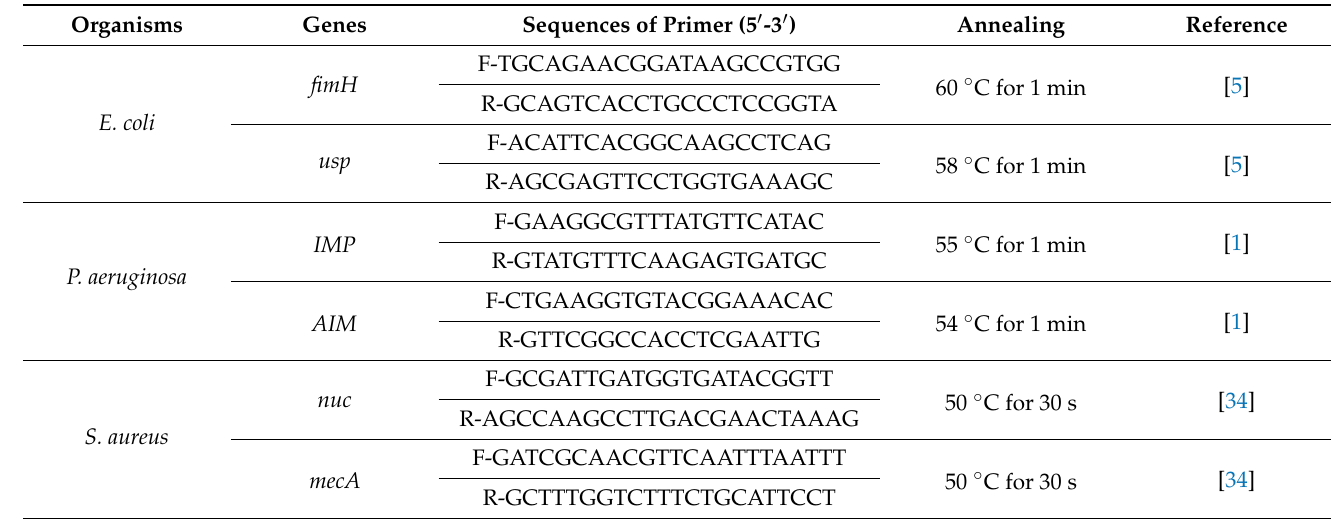
Table 4. Primer sequences of genes of E. coli, P. aeruginosa and